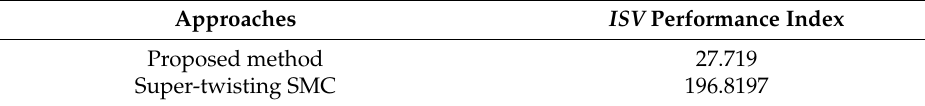
Table 2. Quantitative performance